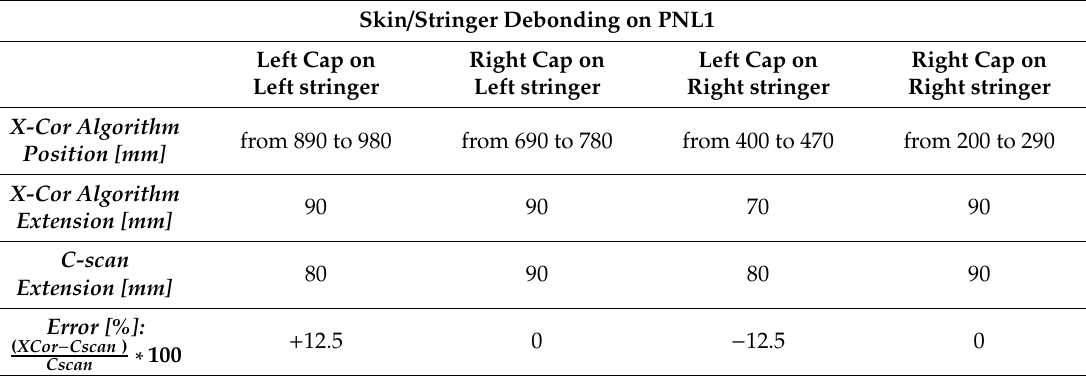
Table 1. Damage position estimation for PNL1.